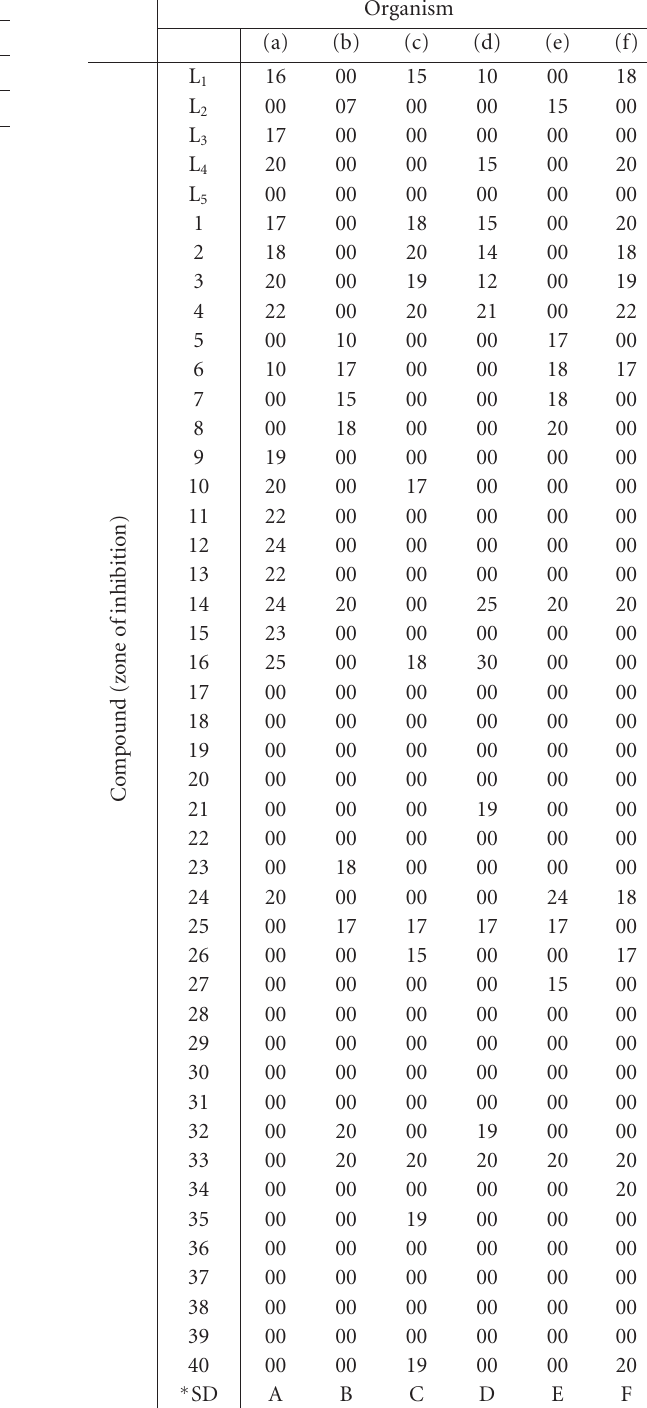
Table 3: Results of antibacterial bioassay (concentration used 1mg/mL of DMSO). (a) E coli , (b) S flexenari , (c) P aeruginosa , (d) S typhi , (e) S aureus , (f) B subtilis 10 < : weak; > 10: moderate; > 16: